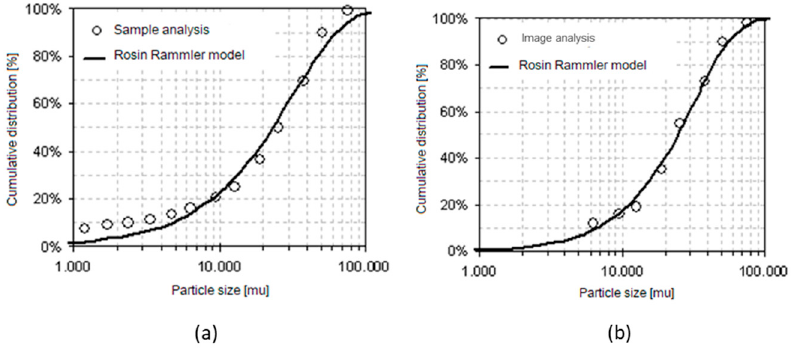
Figure 16. ( a ) Granulometric curves of samples. ( b ) Sensor curve. For images shown in Figure 15.